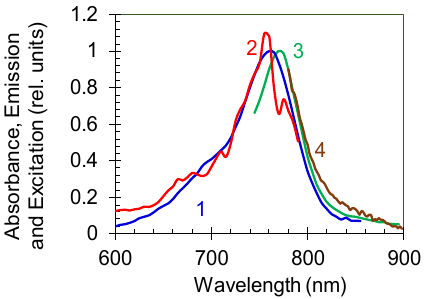
Figure 2: Absorption, excitation, and cw emission spectra of HITC:PMMA dye on the glass substrate with concentration equals 8.5 g/l. Trace 1 – absorption, trace 2 – excitation, trace 3 – cw emission,andtrace 4 – emissionspectrummeasuredat short-pulse pumping. Adapted from ref [20].